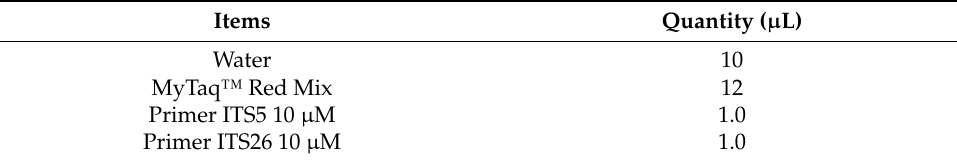
Table 5. Master mix of housekeeping PCRs for both PCN species.